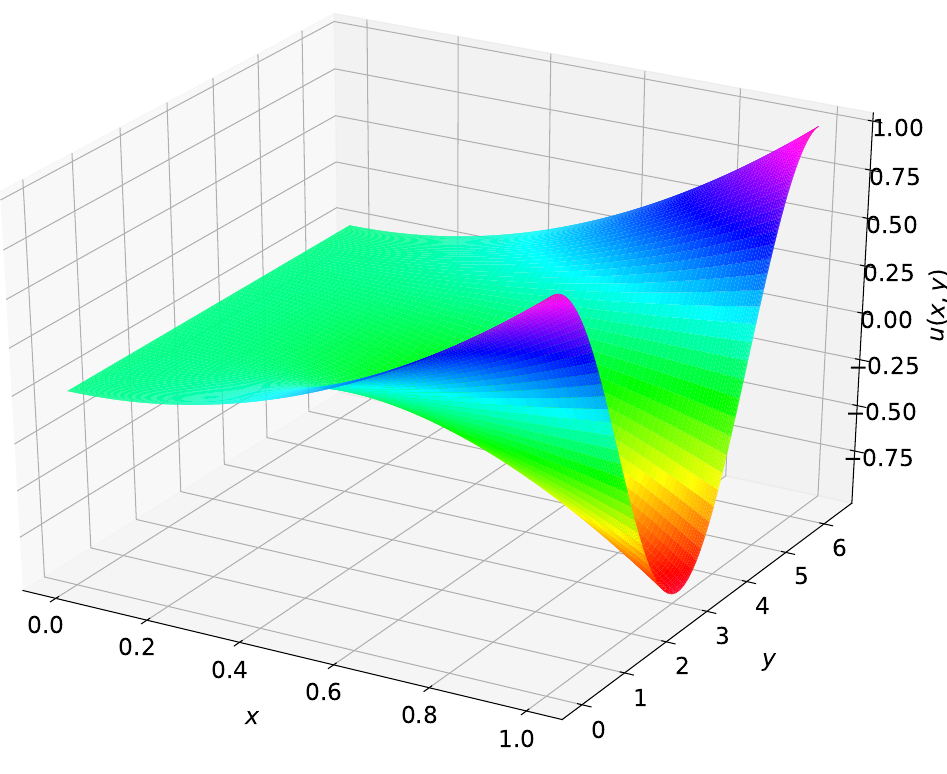
Figure 6. Problem #2 analytical solution. Table 5. Maximum test set solution error using Chebyshev polynomials for Problem # 2.